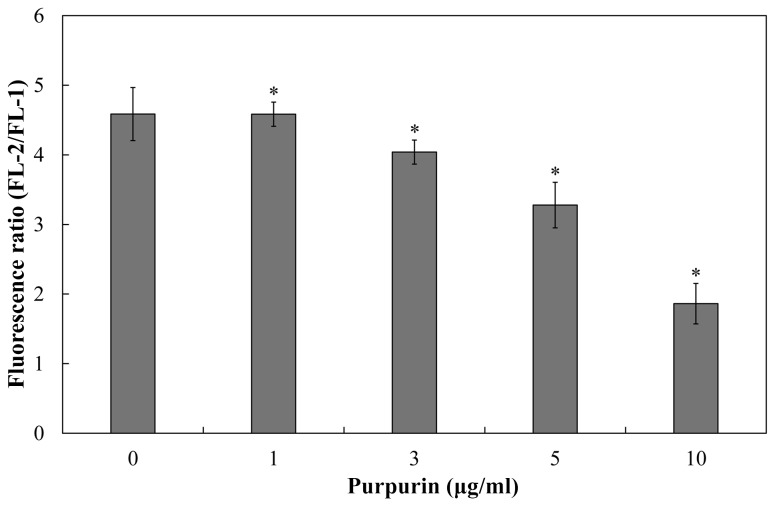
Depolarization of MMP in purpurin-treated Candida dubliniensis biofilms.Purpurin-treated C. dubliniensis biofilms were incubated with JC-1. MMP was measured by flow cytometer at FL-1 (525 nm) and FL-2 (595 nm), and expressed as ratio of FL-2/FL-1. Results shown were the average of three independent experiments ± SD. *p<0.05 when compared with the untreated controls.